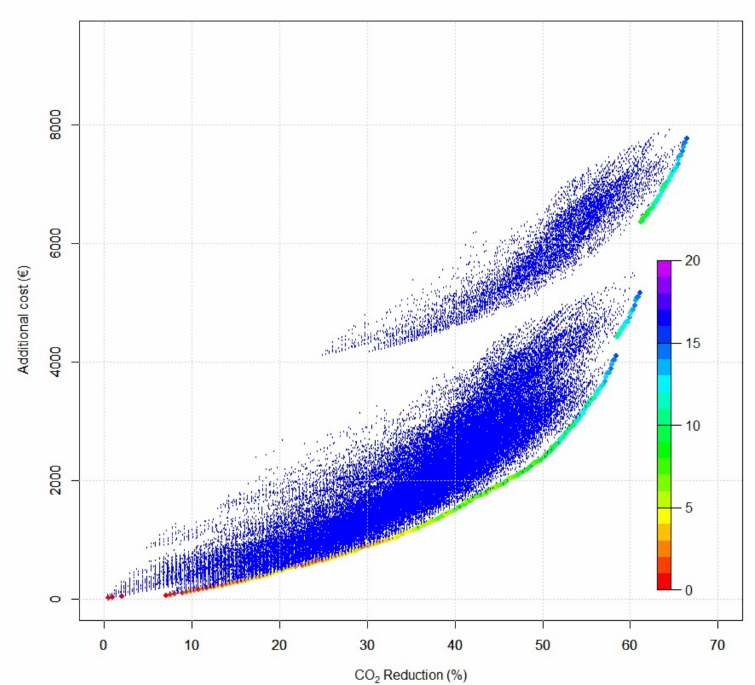
Figure 2. Randomly sampled intermediate configurations visited by the ants (small blue dots) along with optimal configurations found by ACO (colored or grey shades-bigger dots of the Pareto